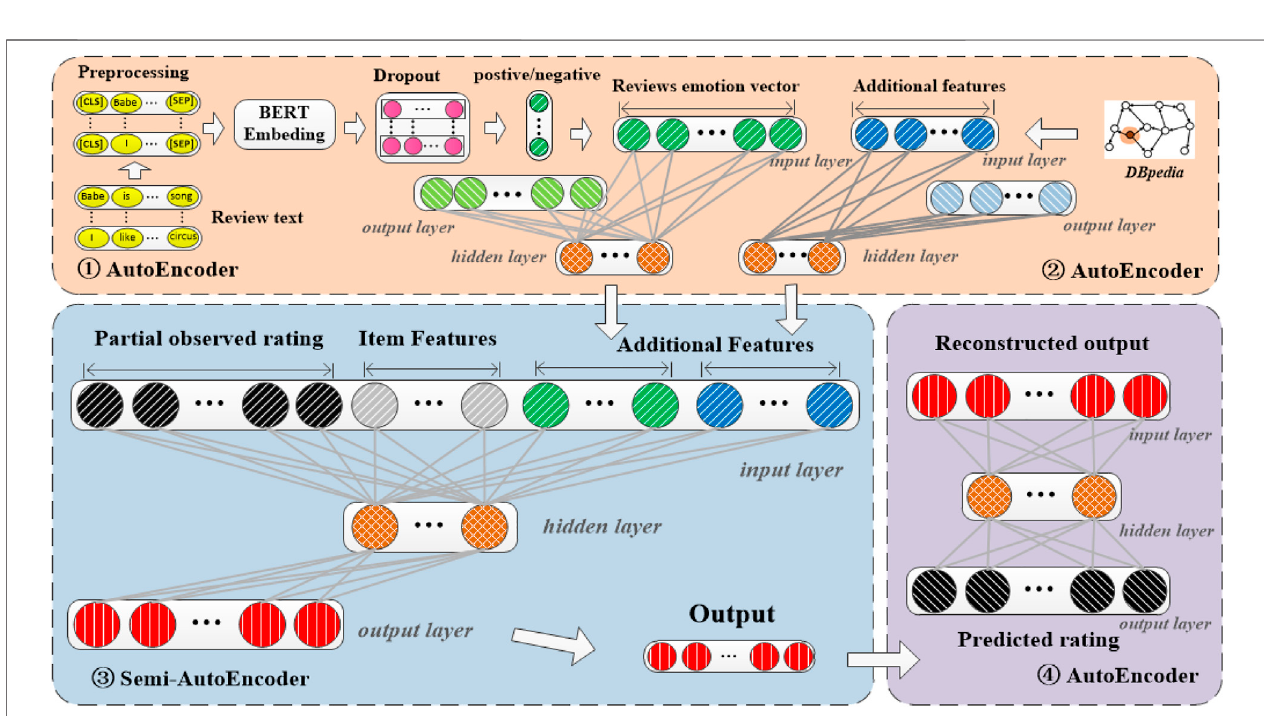
FIGURE 2 | Whole framework of the proposed